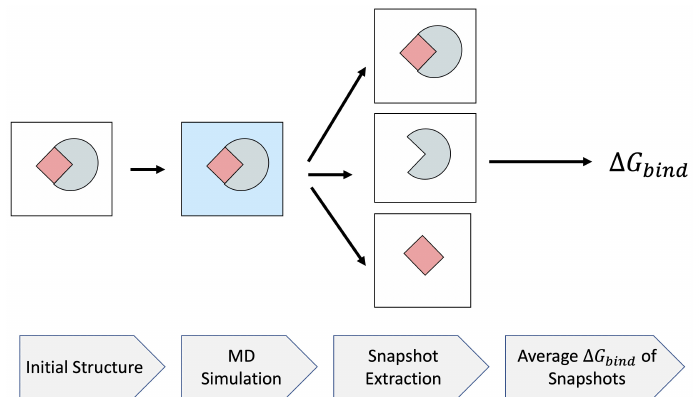
Figure 4. MM/PB(GB)SA flowchart. The initial structure of the complex is solvated using a water model. An MD simulation is run, from which a relatively large number of snapshots are extracted. After removing solvent molecules, the average binding free energy of the snapshots is assigned as the ∆ G bind of the system. The mean and standard deviation of each component of the ∆ G bind are supplemented by